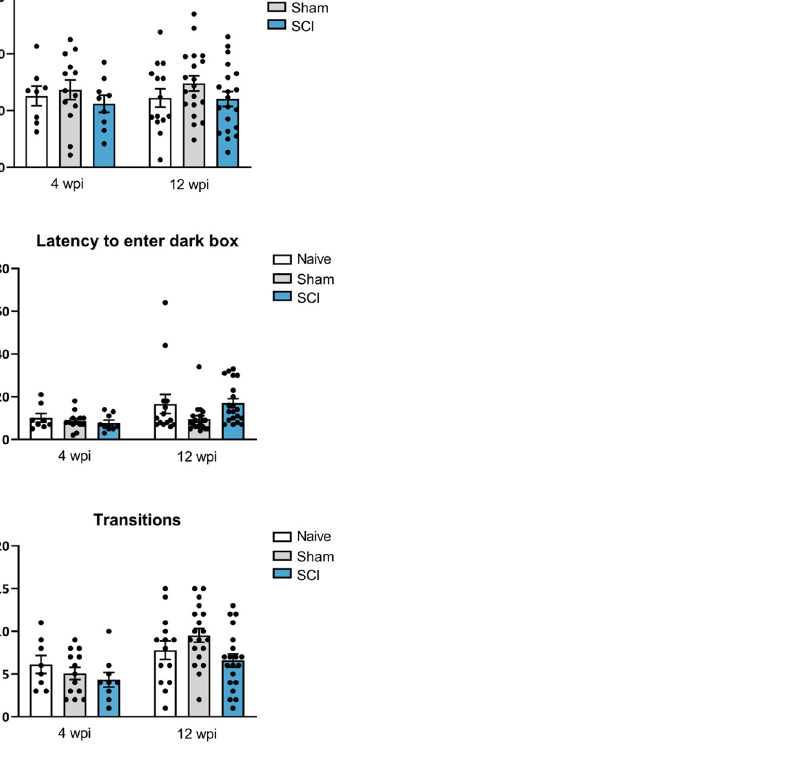
Figure 5. Dark and light box test after mild spinal cord injury (SCI). Time spent in the light box ( A ), the latency to enter the dark box ( B ) and the transitions ( C ) between boxes were evaluated. SCI mice did not show anxiety-like behavior either at 4 wpi or 12 wpi. The results are the mean ± SEM. SCI, spinal cord injury; wpi, weeks post